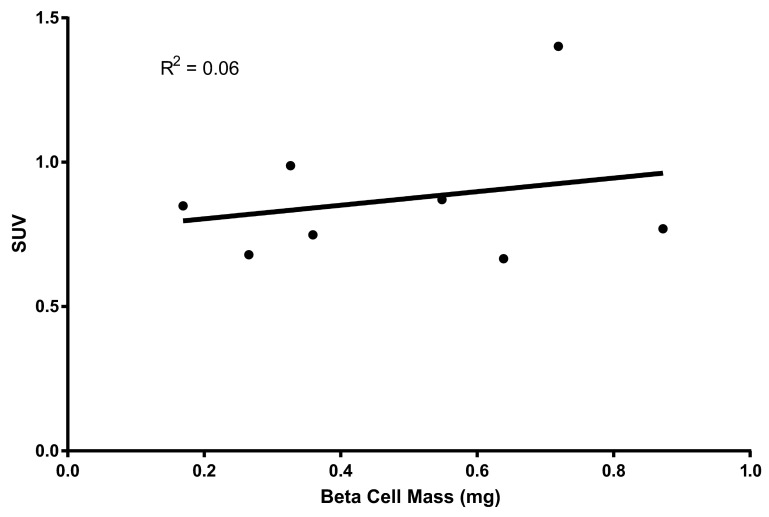
Correlation between beta cell mass and
18F-L-FEHTP uptake.SUVs from static scans from both wt and STZ-treated mice were plotted as a function of beta cell mass. Each point represents values from individual mice. Linear regression analysis showed no significant correlation between SUV and beta cell mass.